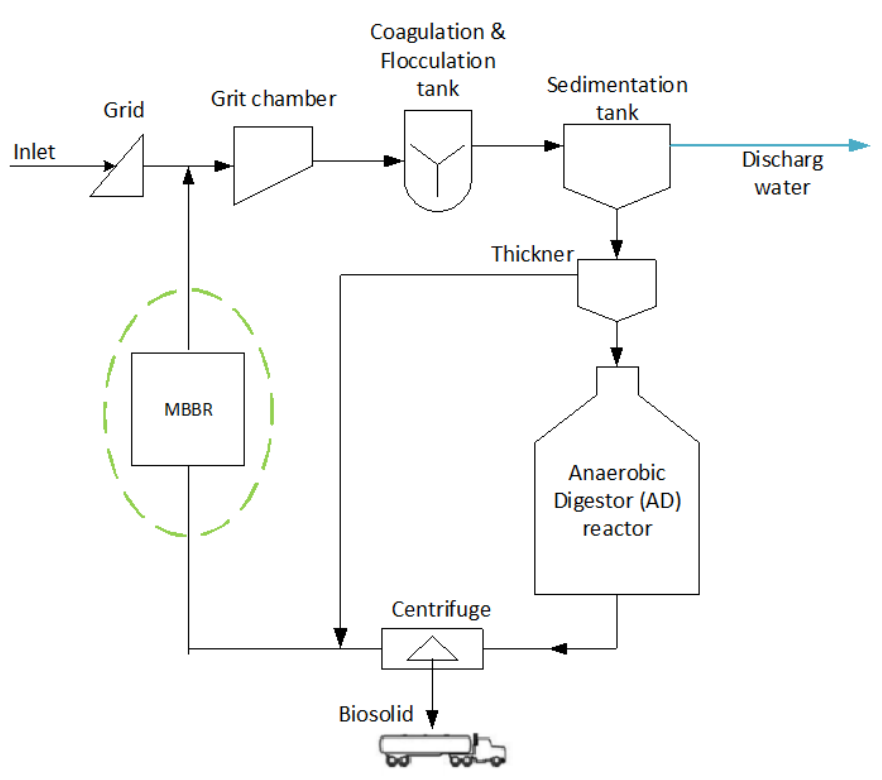
Figure 1. Sketch of the wastewater treatment plant and flow of reject water recycled to the main treatment stream after being treated by MBBR.